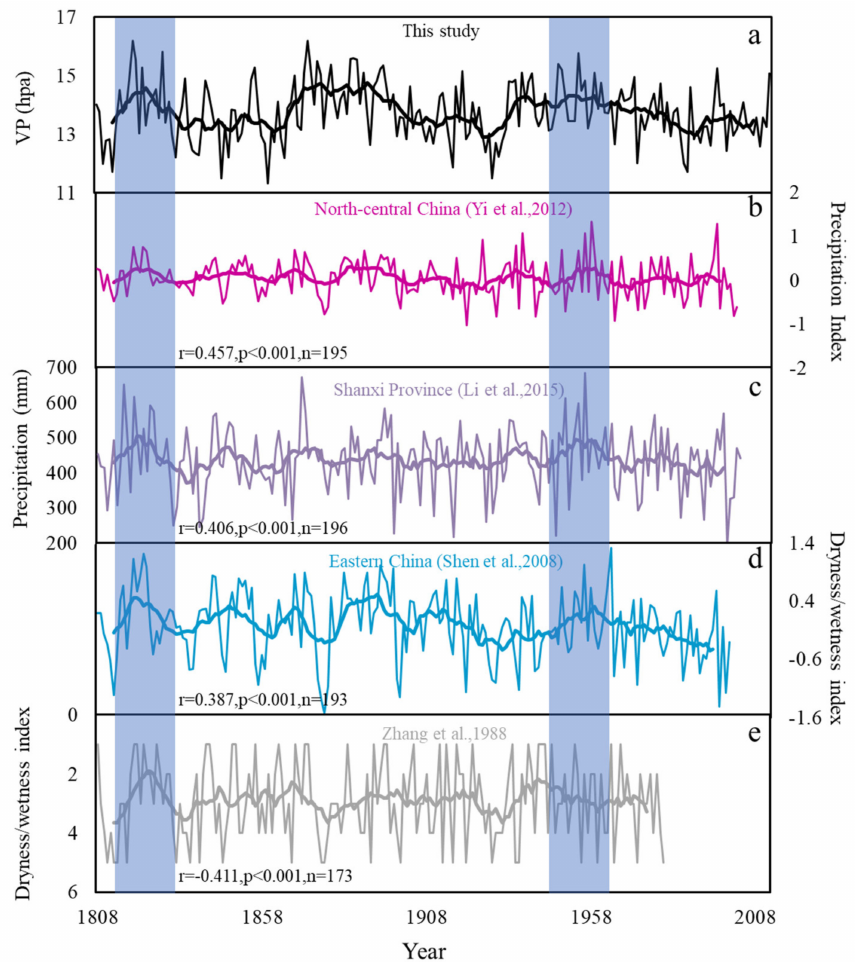
Figure 5. Comparison between reconstructed annual VP JA and existing reconstructions based on other paleoclimatic proxies. The correlation coefficients at the inter-annual time scale are shown. The thick line is an 11-year moving average. ( a ) Reconstructed annual VPJA in Ordos. ( b ) Precipitation index in North-central China reconstructed by Yi et al. 2012 [50]. ( c ) Precipitation in Shanxi province reconstructed by Li et al. 2012 [33]. ( d ) Dryness/wetness index in Eastern China reconstructed by Shen et al. 2008 [41]. ( e ) Dryness/wetness index reconstructed by Zhang et al. 1988